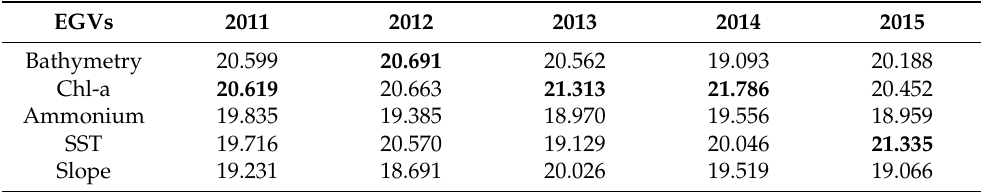
Table 4. EGVs relative contributions (%) to explaining the annual porpoise occurrence probability in each annual ESM. Highest annual contributions are shown in